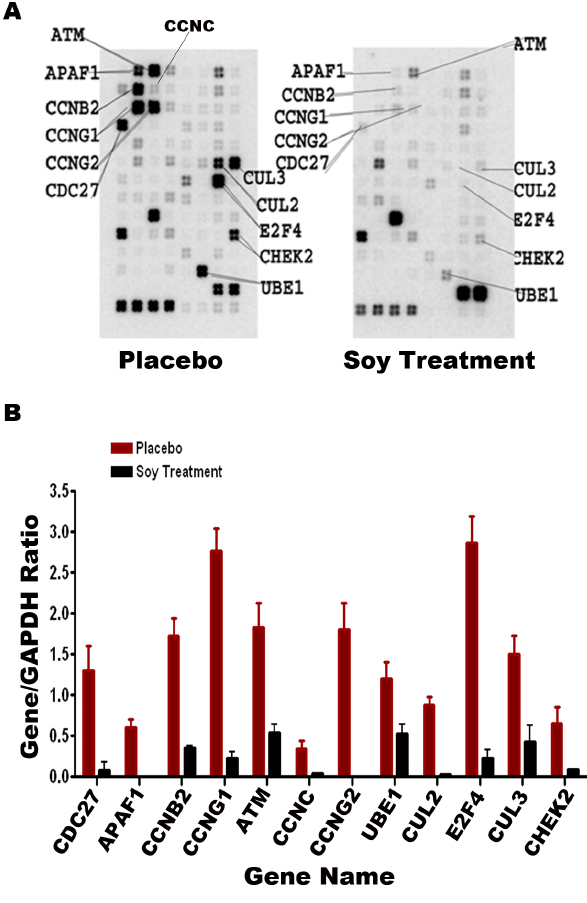
Figure 3. Apoptosis gene array of the prostate tumor specimen obtained from two patients with prostate cancer, one who consumed isoflavones and one who took the placebo. The figure shows the ratio of the gene to GAPDH.